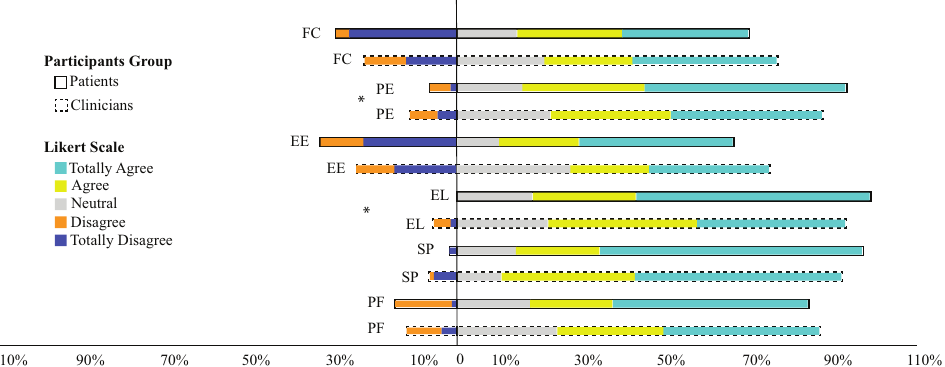
Figure 3. Perception between clinicians and patients. Psychological factor (PF), Social perception (SP), Entertainment Level (EL), Effort’s Expectation (EE), Performance Expectation (PE), and Facility Conditions (FC). (*) Significant differences between patients and clinicians. Table 3. Results of the constructs comparison between clinicians and patients ( Mann Withney Test).